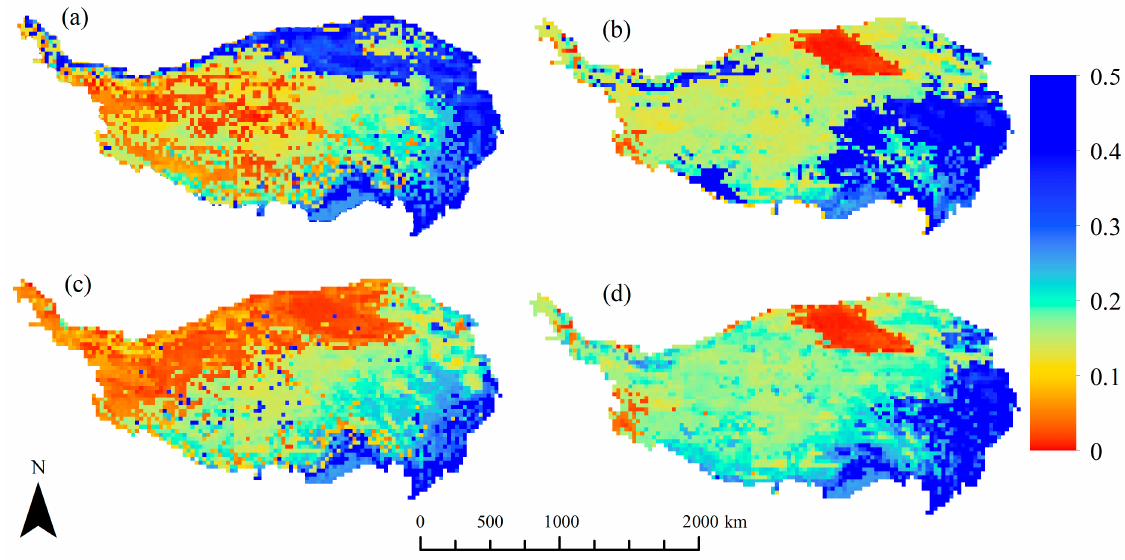
Figure 7. Spatial distributions of the caliburated CCI-C SM data (m 3 /m 3 ) based on zonation by topography ( a ), climate ( b ), land cover type ( c ), and composite climate-vegetation ( d ).